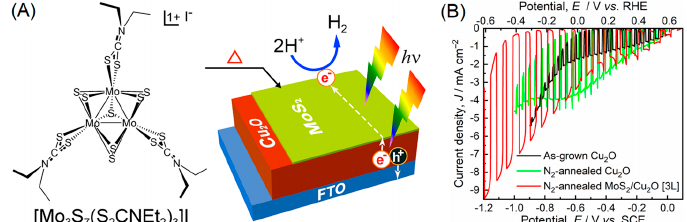
Figure 1. ( A ) Schematic showing the formation of a proton reduction catalytic MoS 2 layer on top of a p-type Cu 2 O via spin coating [Mo 3 S 7 (S 2 CNEt 2 ) 3 ]I and thermal annealing. Cu 2 O was electrodeposited on fluorine-doped tin oxide (FTO) substrate; and ( B ) photocurrent responses of as-grown Cu 2 O, N 2 -annealed Cu 2 O, and N 2 -annealed MoS 2 -modified Cu 2 O photocathodes under intermittent light